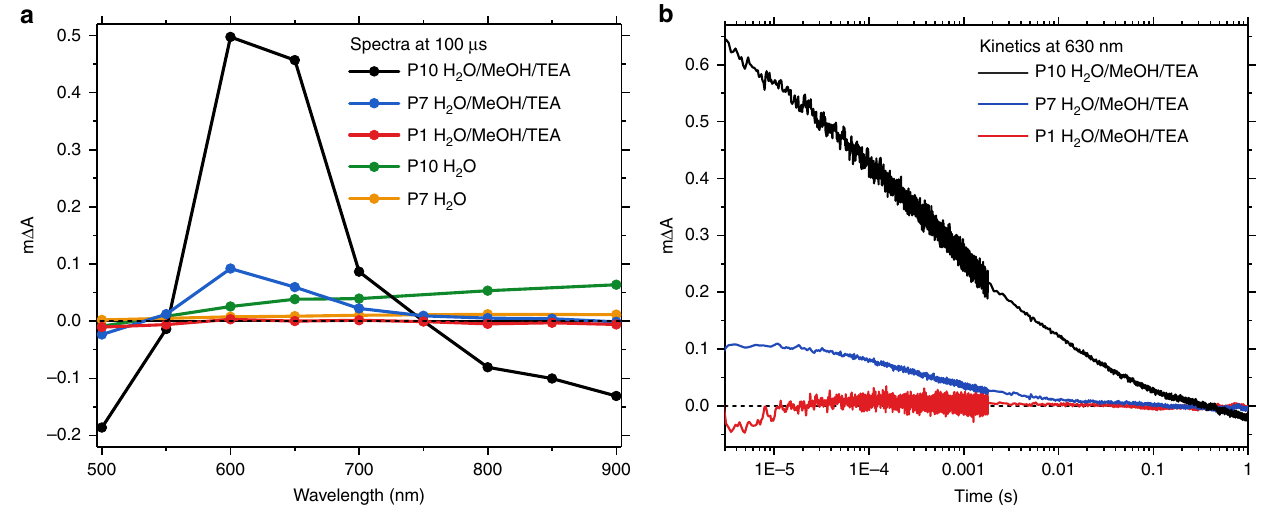
Fig. 3 Spectral signatures of photogenerated reaction intermediates and their temporal evolution on the μ s – s timescale. a Transient absorption spectra probed 100 µ s after excitation for P10, P7, and P1 in the H 2 O/MeOH/TEA reaction mixture and for P10 and P7 in water alone. The spectrum for P1 in H 2 O is omitted as no appreciable signal was observed. b Transient kinetics probed at 630 nm for P10, P7, and P1 in the reaction mixture. All data were obtained at an excitation wavelength of 355 nm and a fl uence of 0.32 mJ cm −